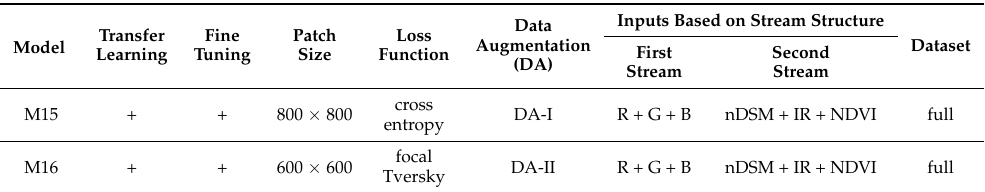
Table 7. Features of different training approaches and inputs using the full datasets for dual-stream segmentation models.